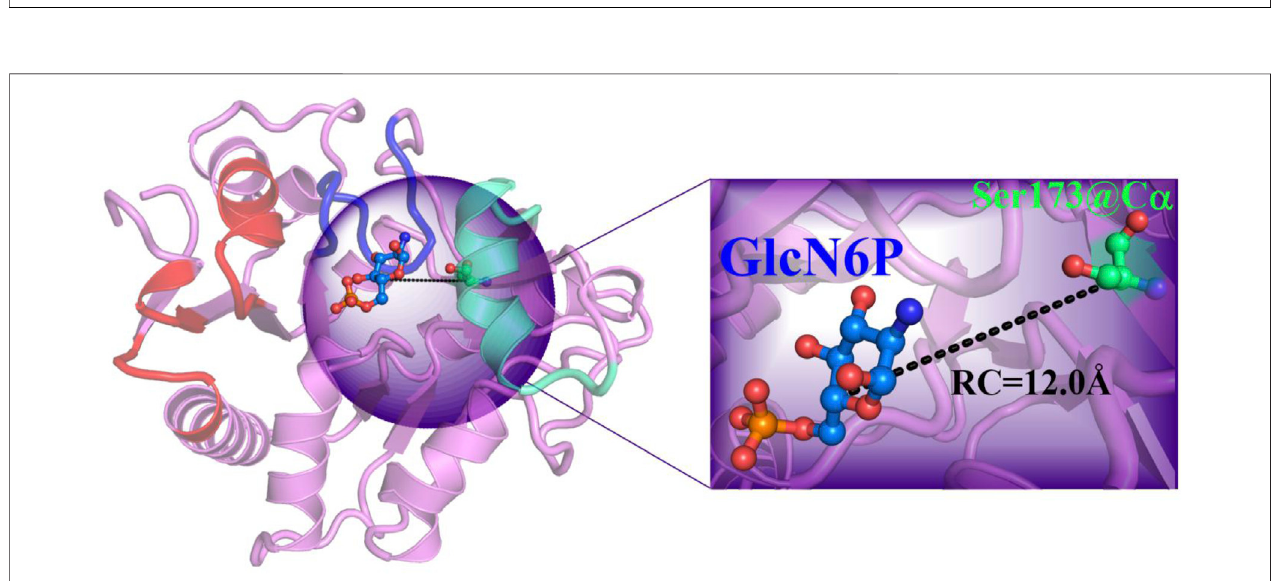
FIGURE 5 | Key segments in the possible channels for the delivery of GlcN6P from Smu NagB as determined by RAMD MD simulations. [ (A) : Loop 1: residues 6 – 10; Loop 2: 122 – 136; Helix 1: 222 – 233; Helix 2: 189 – 198; Helix 3: 150 – 163]. (B) : red shading indicates the fragments of Loop 1, Helix 1, and Helix 2. Green shading denotes the fragments of Helix 3, and blue shading represents the fragment of Loop